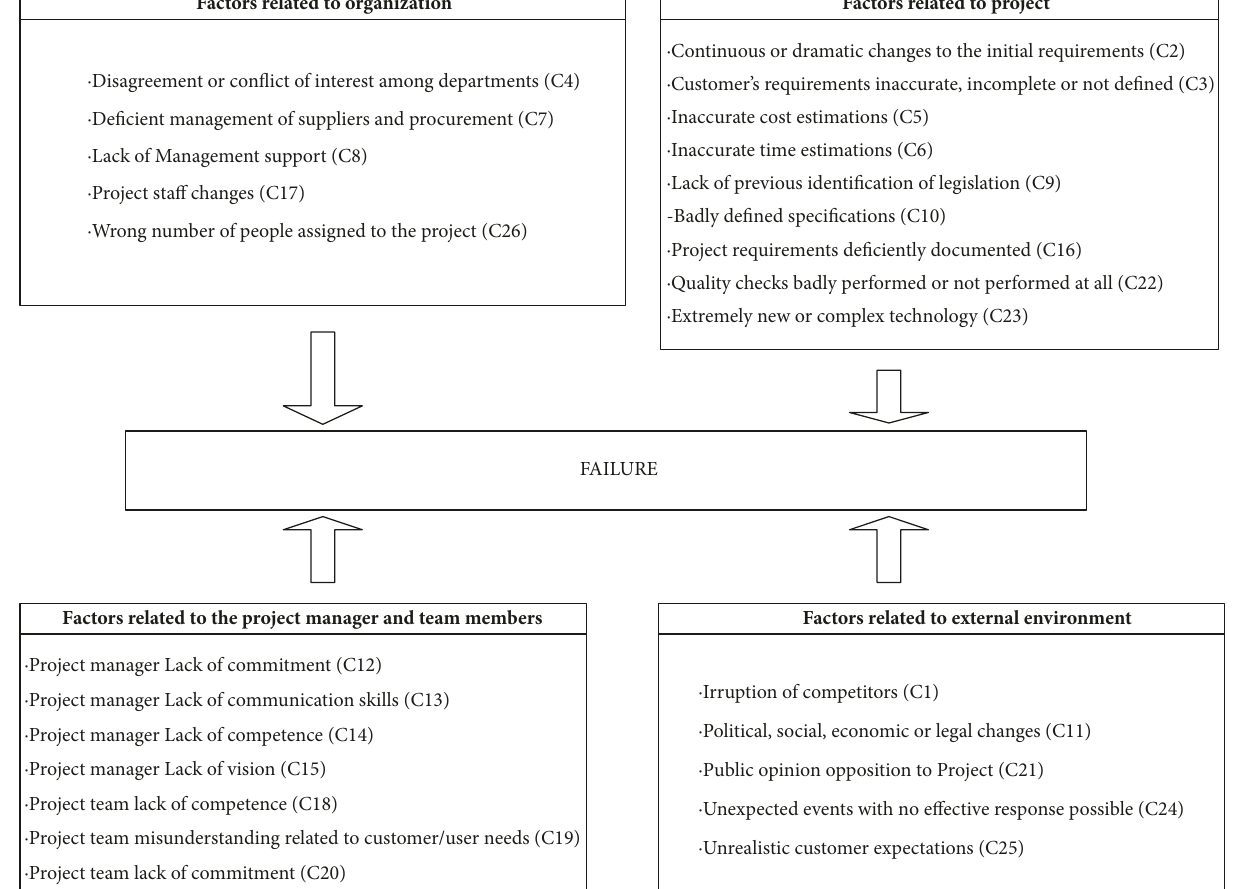
Figure 1: Failure causes grouped by category. The factors are derived from existing bibliography and previous work on the matter. They have been classified according to Belassi and Tukel